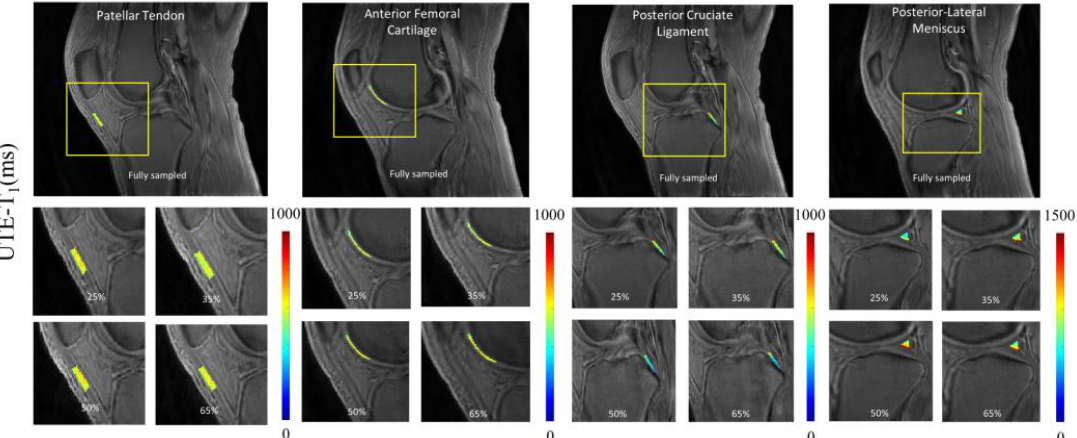
Figure 5. Quantitative mapping of UTE-T 1 parameter at different undersampling levels in four representative ROIs. A representative region is chosen from each group, namely tendon (patellar tendon), cartilage (anterior femoral cartilage), ligament (posterior cruciate ligament), and meniscus (posterior lateral meniscus). The T 1 quantification values ranged between 500 to 1000 ms. The parameter maps show high correlation between different undersampled maps except posterior lateral meniscus, with values between 900 and 800, a margin of 100 ms.